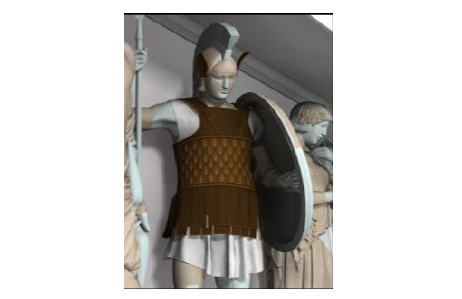
Figure 15. Reconstruction of the lost metal attachments (cuirass and cheek-pieces) of figure